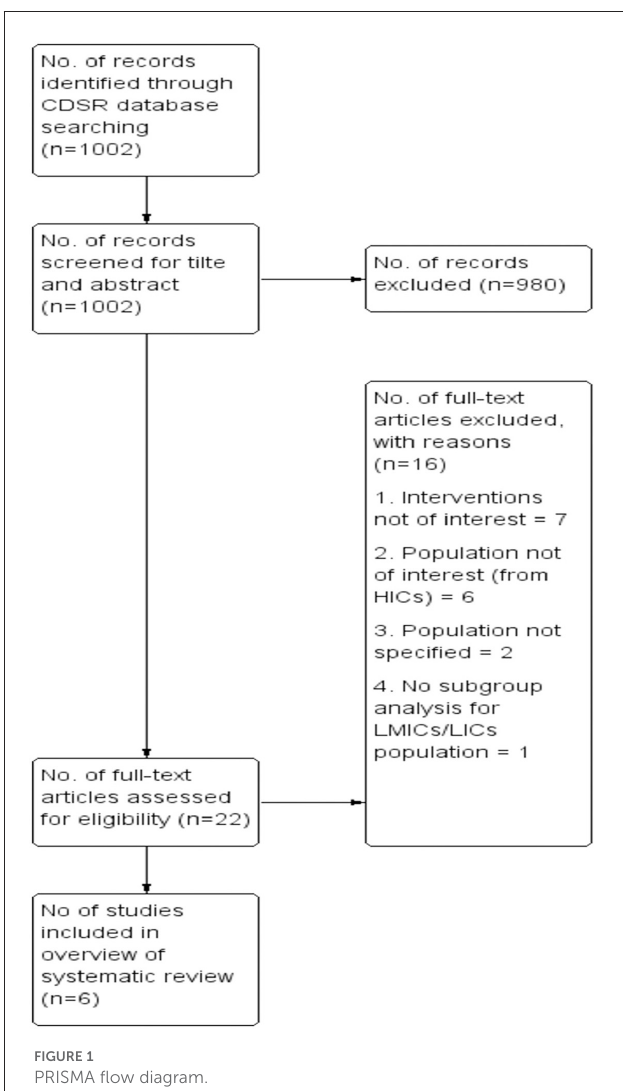
FIGURE1 PRISMA flow